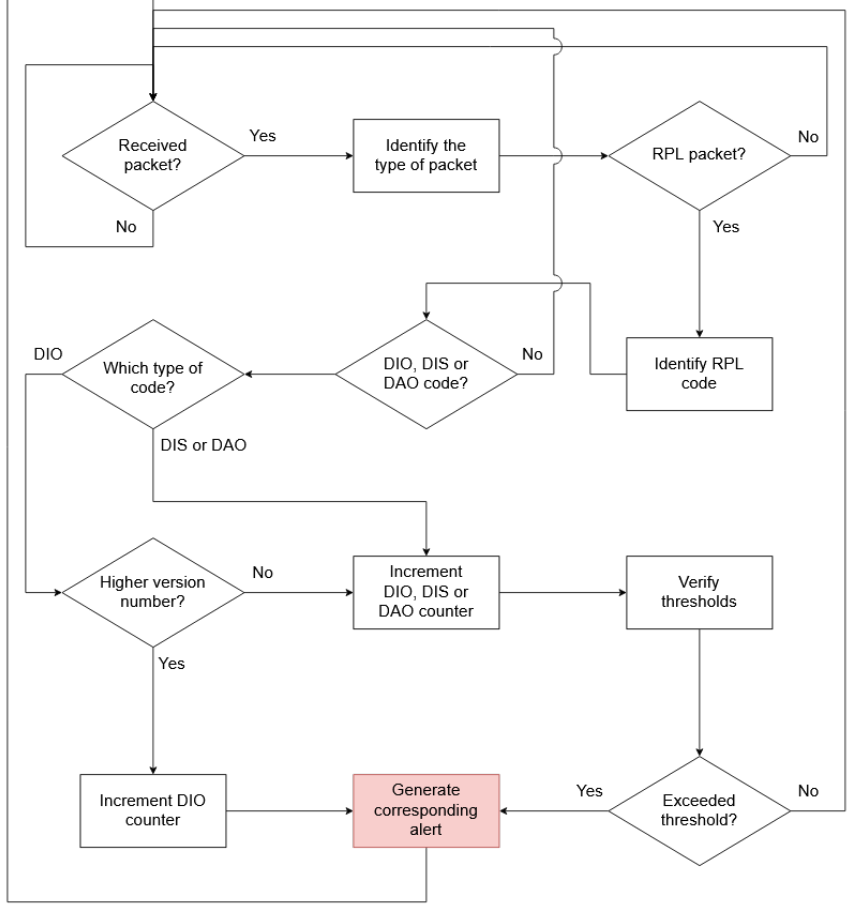
Figure 2. Central IDS detection